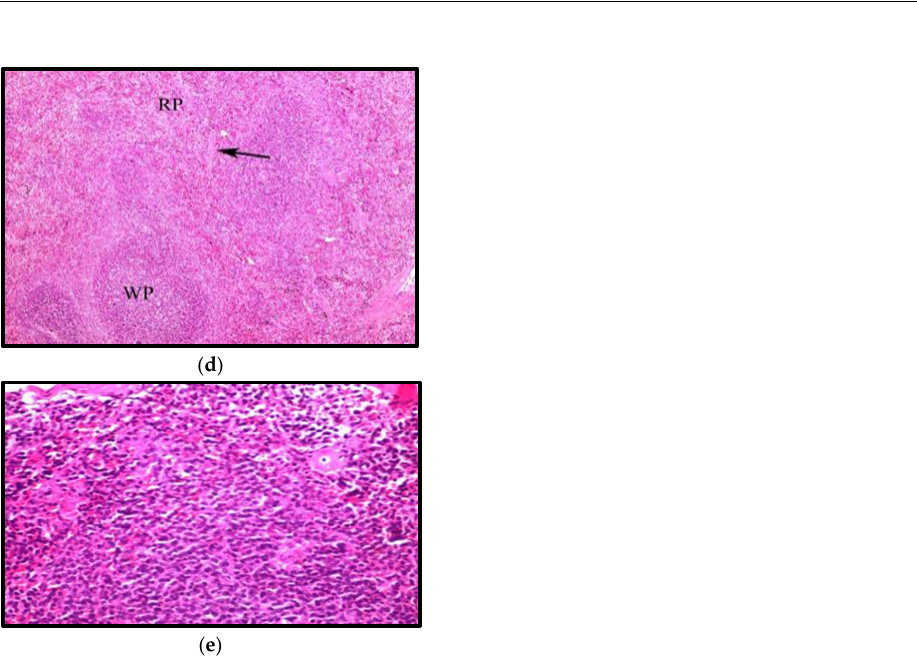
Figure 7. Histology of spleen section stained with hematoxylin and eosin (original magnification ×200) from each group: G5: high-cholesterol diet (Ch); G6: Ch + Lp + Lc; G7: Ch + Sp; G8: Ch + Lp + Sp; G9: Ch + rosuvastatin. ( a ) G5: Section in splenic tissue showing degenerative changes in the lymphocytes of the red pulp (R) and megakaryocytes (arrow) (H&E. 400×). ( b ) G6: Section in splenic tissue showing interstitial hemorrhage in the splenic sinusoid with brown pigments (arrow) (H&E. 400×). ( c ) G7: Section in splenic tissue showing normal appearance of white and red pulp elements (H&E. 400×). ( d ) G8: Section in splenic tissue showing normal appearance of white pulp (wp), red pulp (Rp) and the splenic trabecula (H&E. 400×). ( e ) G9: Section in splenic tissue showing a reduction in the white pulp elements (H&E. 400×).